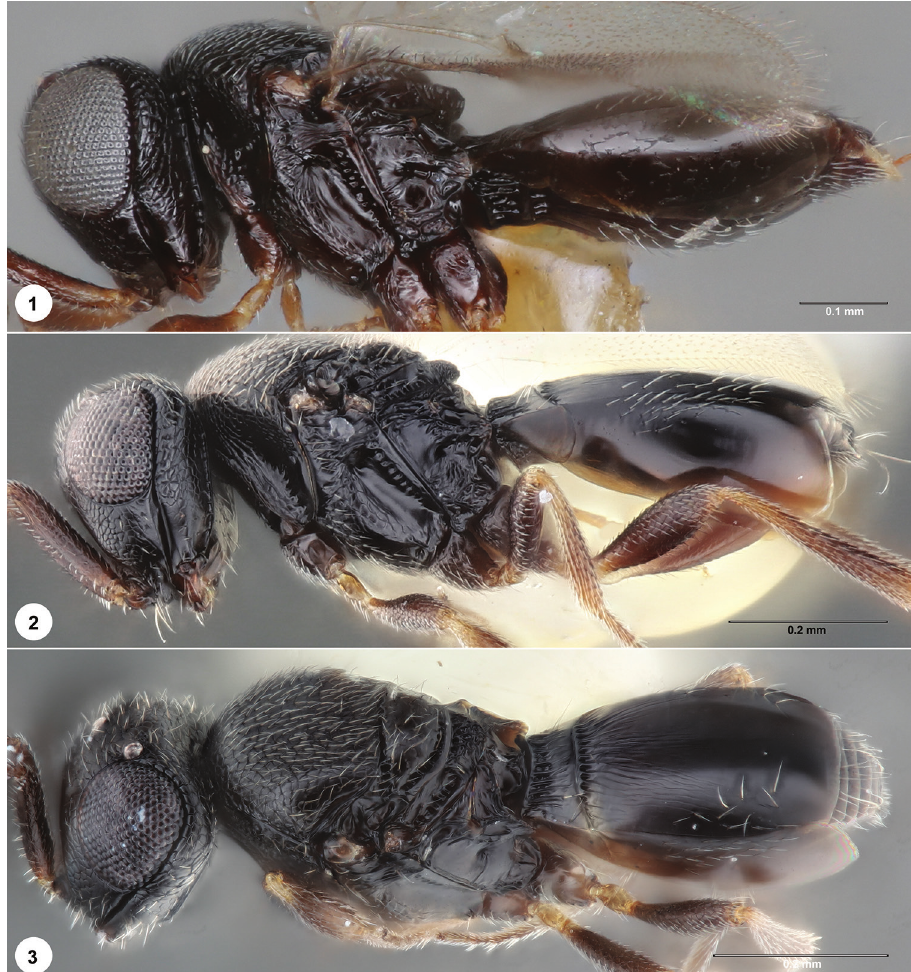
Figures 1–3. Telenomus fariai 1 female (USNMENT01795654), identified by Costa Lima, reared from Triatoma eggs in Brazil, lateral habitus 2 female (FSCA 00091164), reared from Tr. dimidiata in Mexico 3 male (FSCA 00091165), reared from Tr. dimidiata in